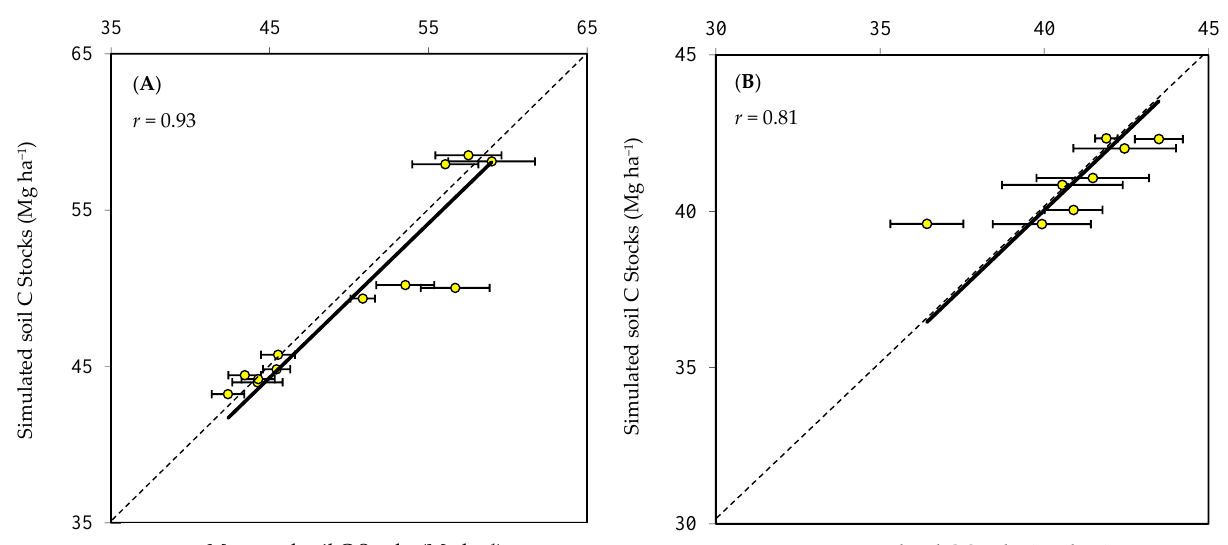
The data are measured and simulated mean values for the farm-scale study, n = 67 for conventional system, n = 59 for organic system, n = 47 for non-grazed regime and n = 79 for grazed regime, for the NFSC trial, n = 32 for crop rotation, fertility source and year of sampling. The standard error of the mean is in parentheses.